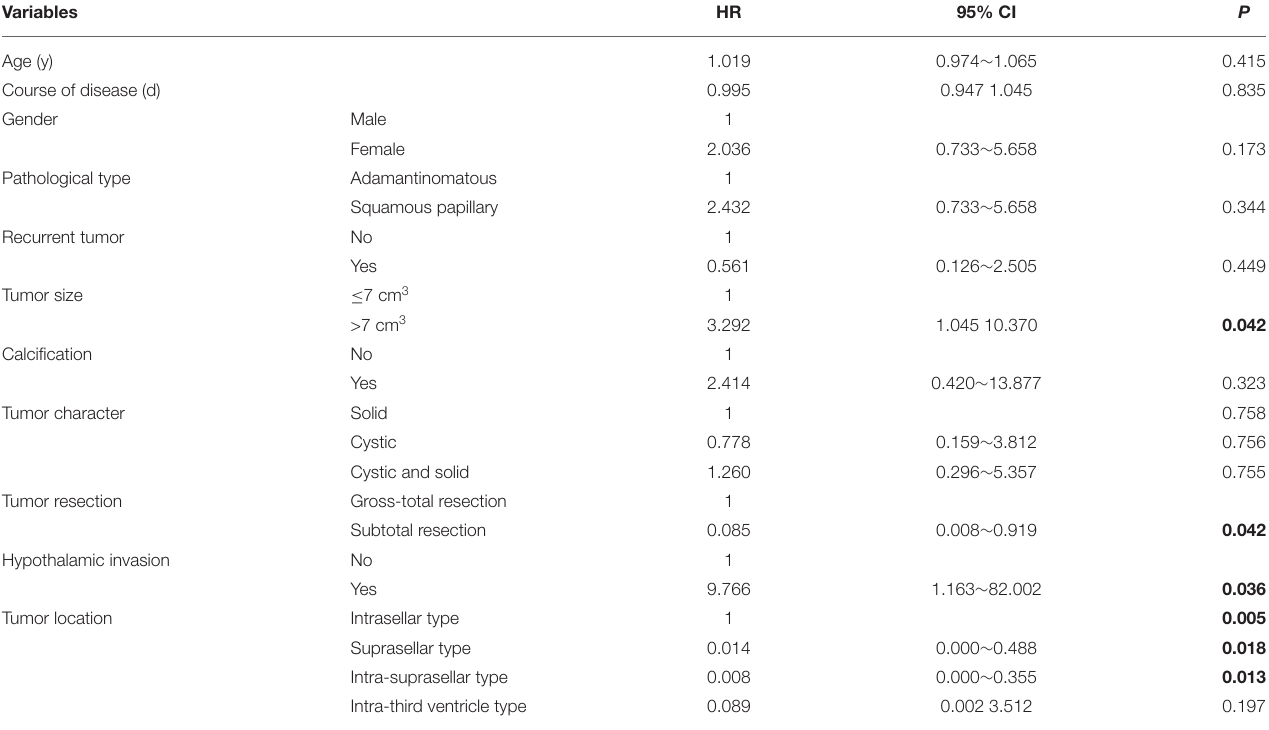
TABLE 5 | Factors associated with psychiatric disorders -Multivariate analysis.